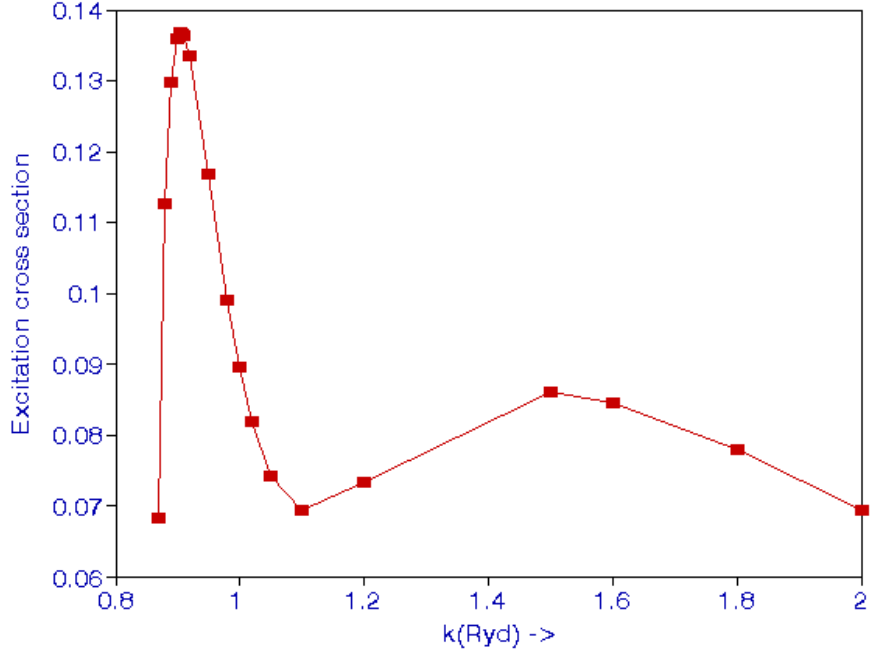
Figure 2. (Color online). Cross-sections (Mb) for the 2S state excitation of atomic hydrogen from the 1S state by an electron impact.